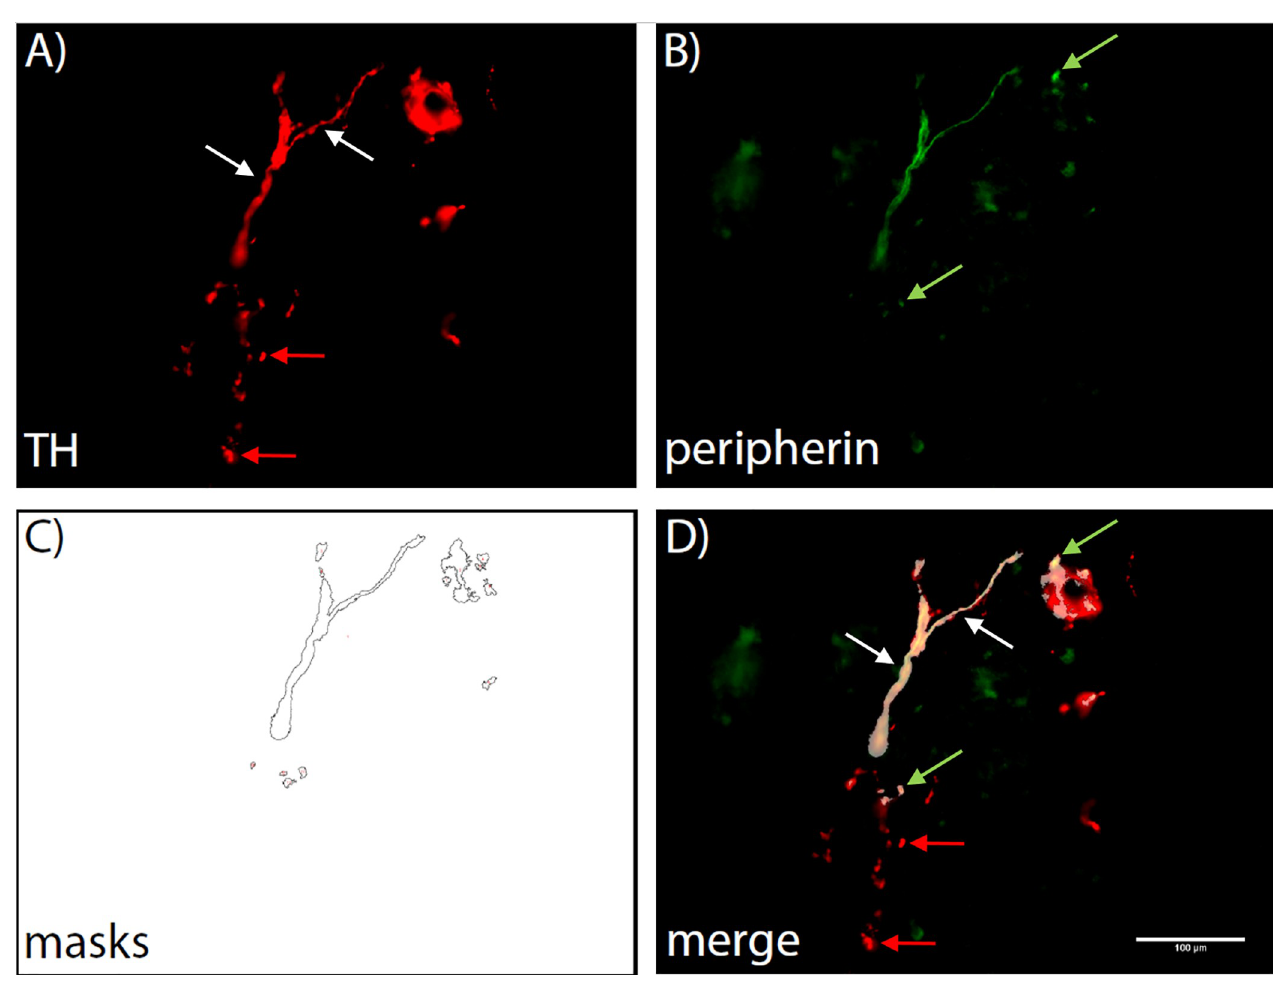
Fig 1. Exemplary image of TH–Peripherin co–Staining and comparison between manual and automatic method in a wildtype spleen section. A) TH positive fibers are identified by red staining (alexa fluor 594). 2 fibers comply with the selection criteria (oblong shape of over 50 μ m in length) for manual counts (white arrows). B) Peripherin is labeled green (alexa fluor 488). C) 13 counting masks established by automatic counting in ImageJ. D) Merged image. Magnification is 400 fold. Green arrows indicate laterally sectioned sympathetic fibers determined by TH–peripherin double positivity.